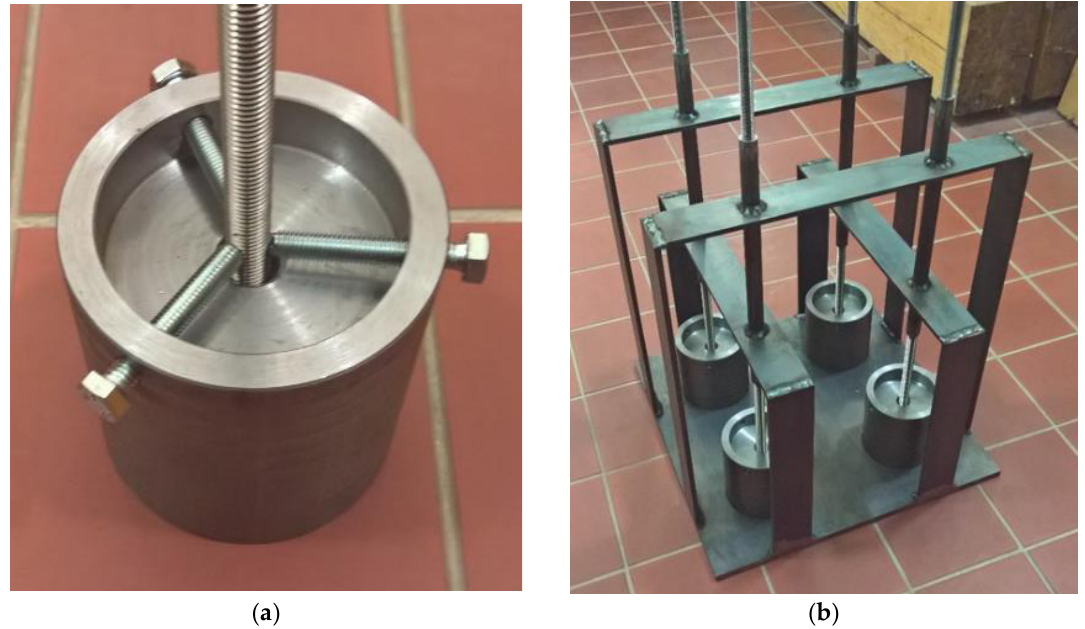
Figure 6. ( a ) Steel test specimen with the locking screws; ( b ) Four steel test specimens in mounting jig keeping anchor bolts in the exact vertical positions.